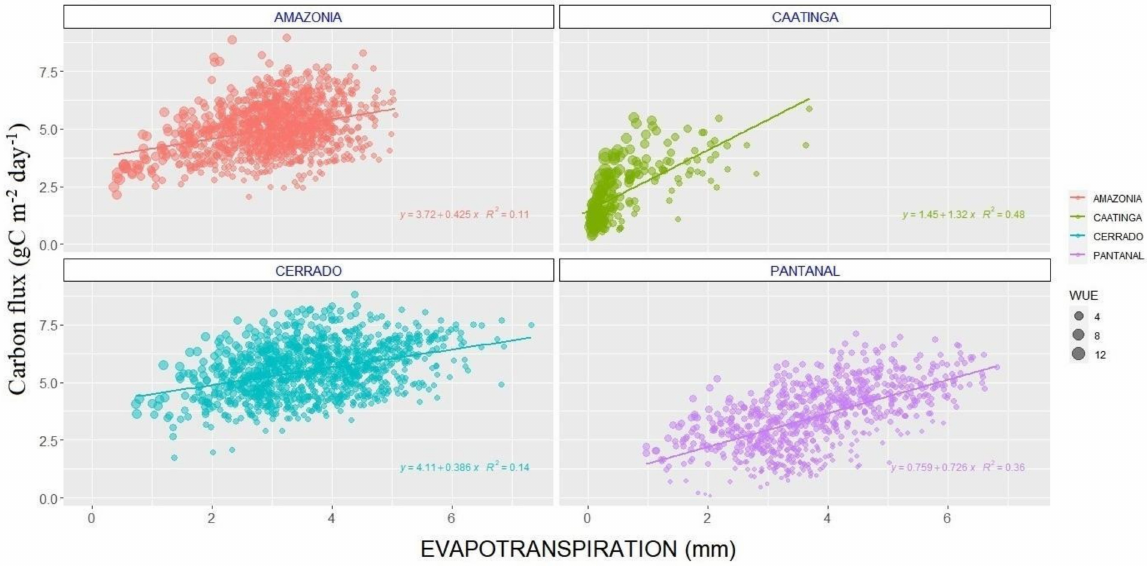
Figure 8. Correlation between daily GPP averages and evapotranspiration for each site. The size of the circles indicates the intensity of water-use efficiency (WUE) estimated at each day (gC kg H 2 O day − 1